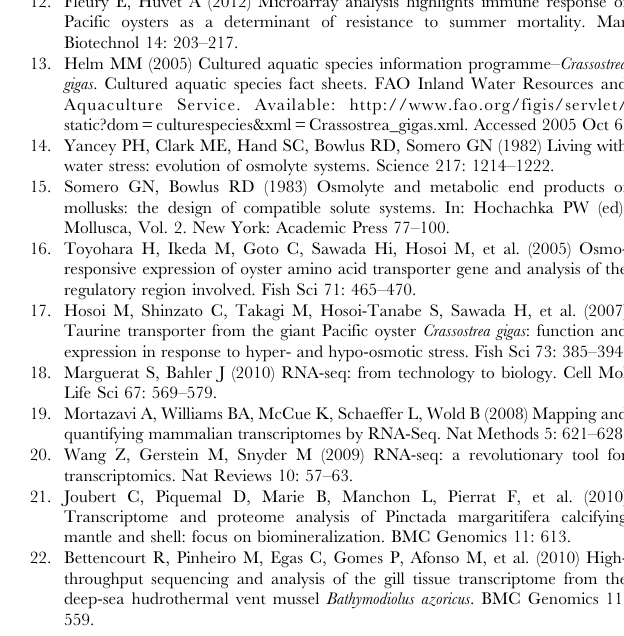
Table S1 List of functional groups and related gill up- regulated genes from oysters in response to hypoosmot- ic stress versus in optimal salinity conditions. Table S2 List of functional groups and related gill down-regulated genes from oysters in response to hypoosmotic stress versus in optimal salinity condi- tions.